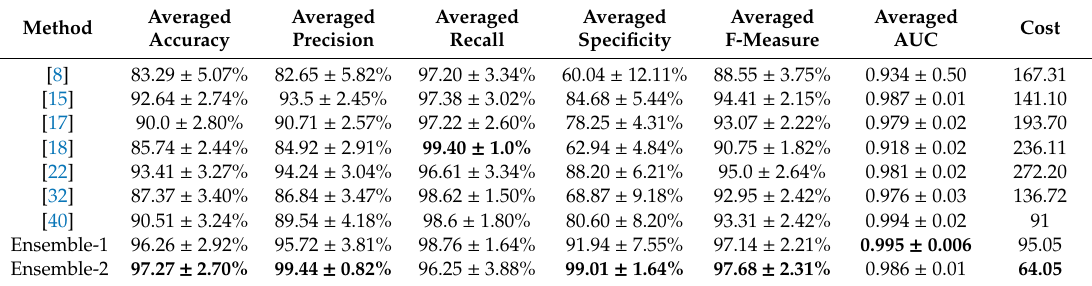
Table 15. Multiple combinations of scoring functions and their respective results.